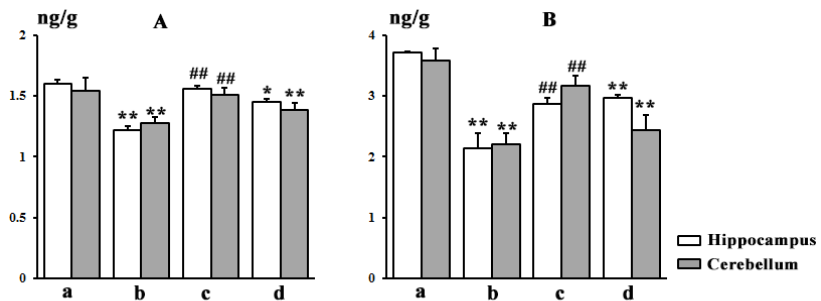
Figure 9. The brain-derived neurotrophic factor (BDNF) ( A ) and nerve growth factor (NGF) ( B ) levels of different group in the hippocampus and cerebellum. (a) control group; (b) SA group; (c) high dose TGP group; (d) positive group. (* p < 0.05, ** p < 0.01 other groups vs. control group; # p < 0.05, ## p < 0.01 TGP group vs. SA group).